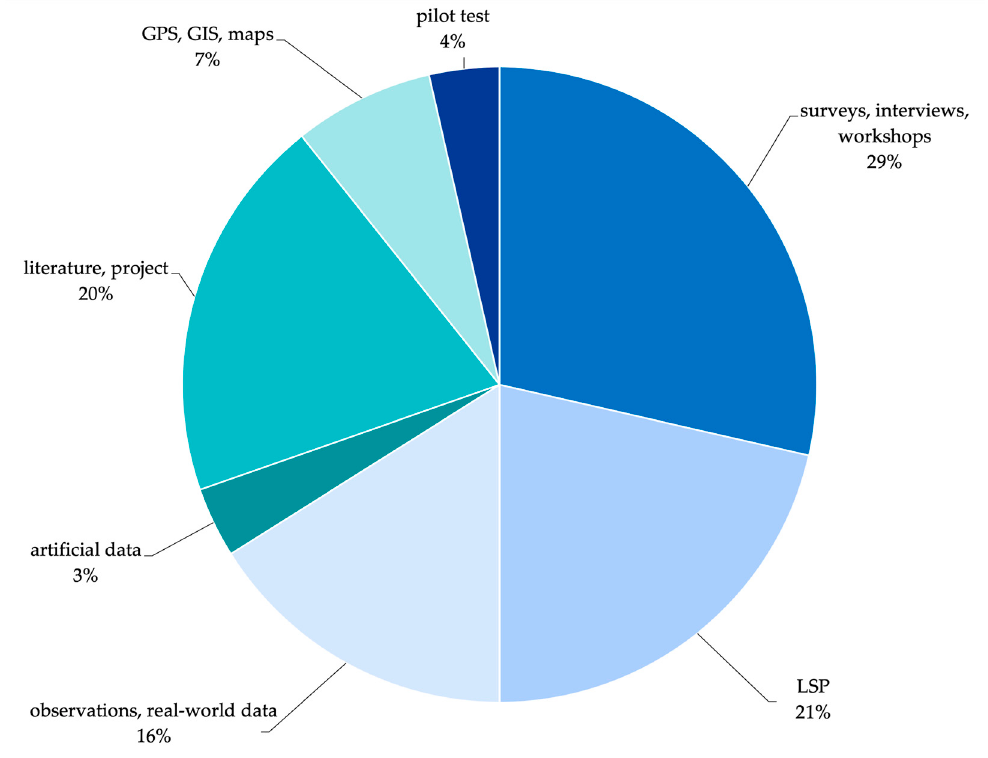
Figure 1. Rating of the most frequently used data sources.